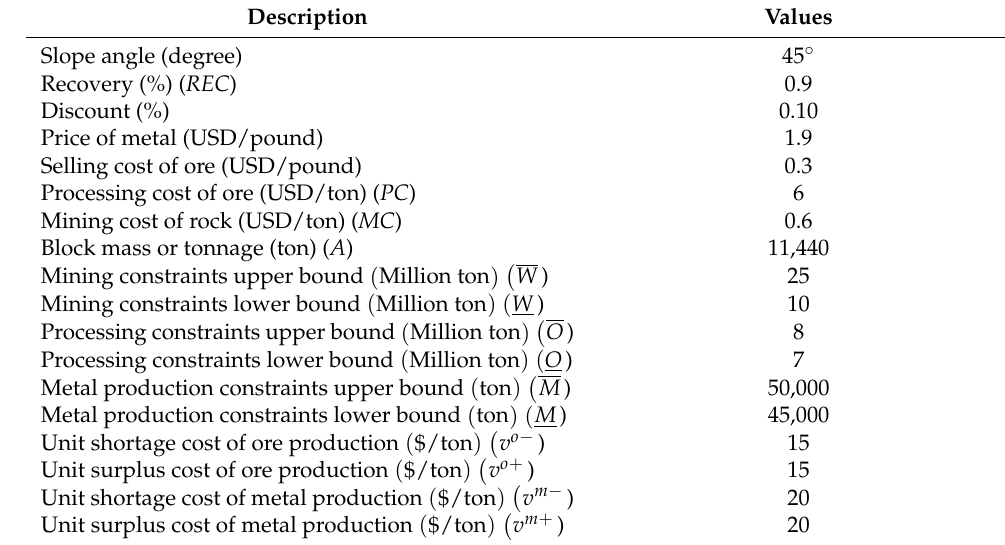
Table 3. Details of economic parameters and constraints